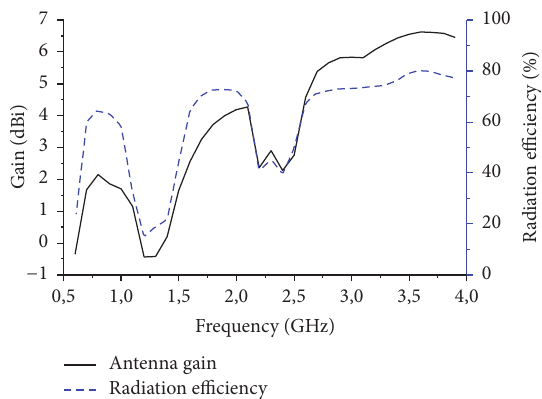
Figure 9: Gain and radiation efficiency of the proposed PIFA.